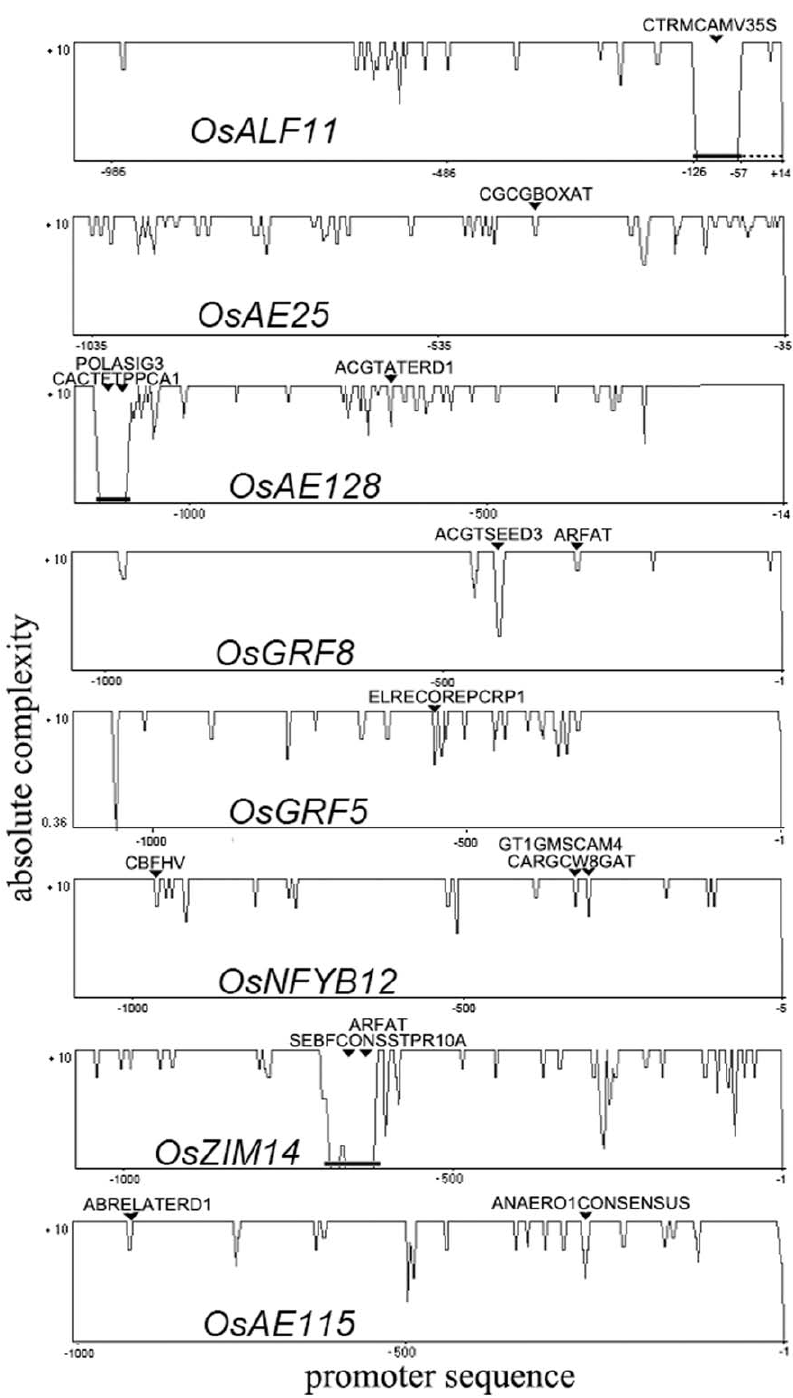
Figure 3. Sequence complexity of associated genes from five varieties. Black lines represent an insertion. Broken lines represent the repeat of the insertion. The arrows indicate that one or more than one site of cis -acting regulatory DNA elements were inserted into the promoters. The abscissa represents the distance to the transcription start sites. doi:10.1371/journal.pone.0030765.g003 production. Among them, the OsZIM14 gene can control the development of plant inflorescences [36]. The cDNA-AFLP analysis of upland rice also substantiated that upland rice varieties could redeploy some development elements to ensure better growth and development potential [41].